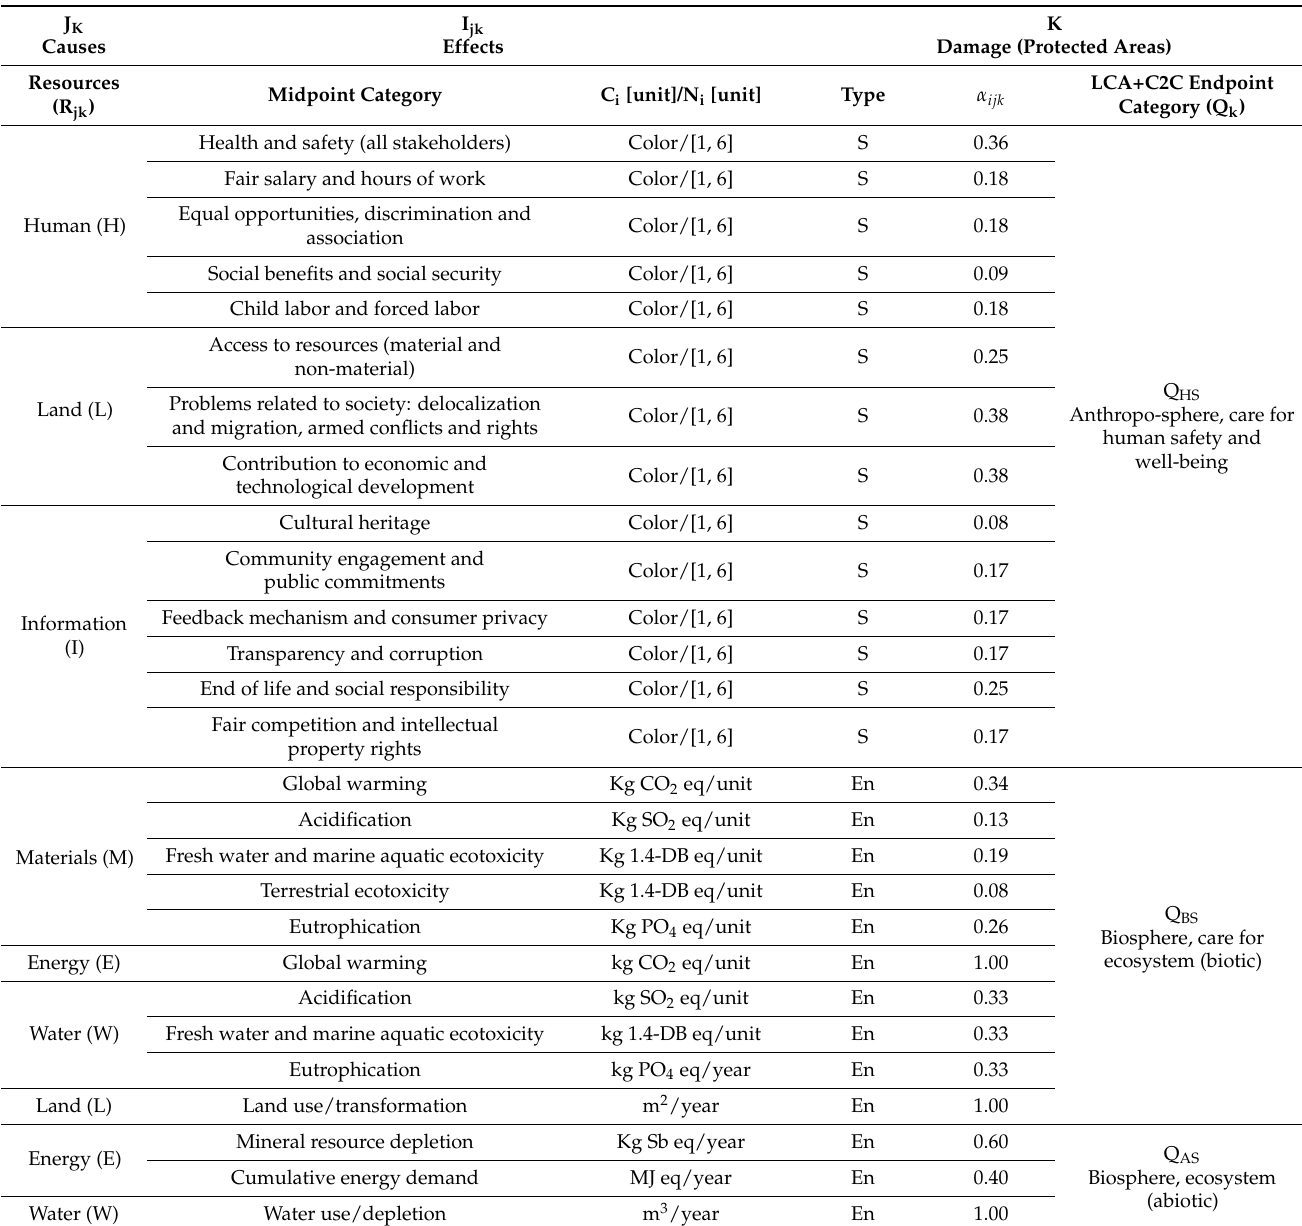
Group III or improvement categories : Set of global sustainable performance indica- tors. These analyze and establish the strategies for the Continuous Improvement Plan life cycle assessment score as an index of the environmental, economic and social footprint. The results are compiled in the Future Effects Inventory